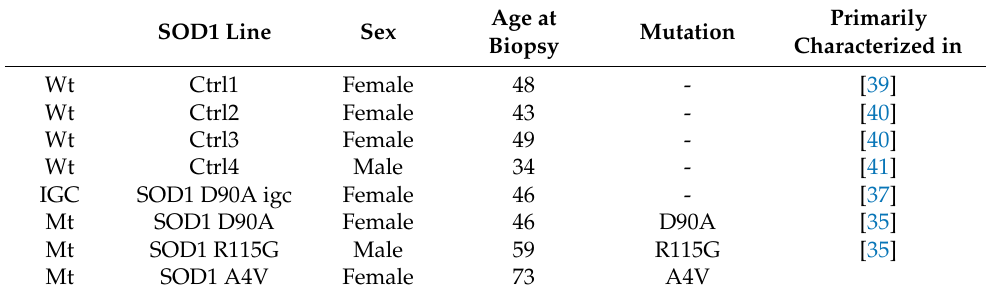
Table 1. Patient/proband